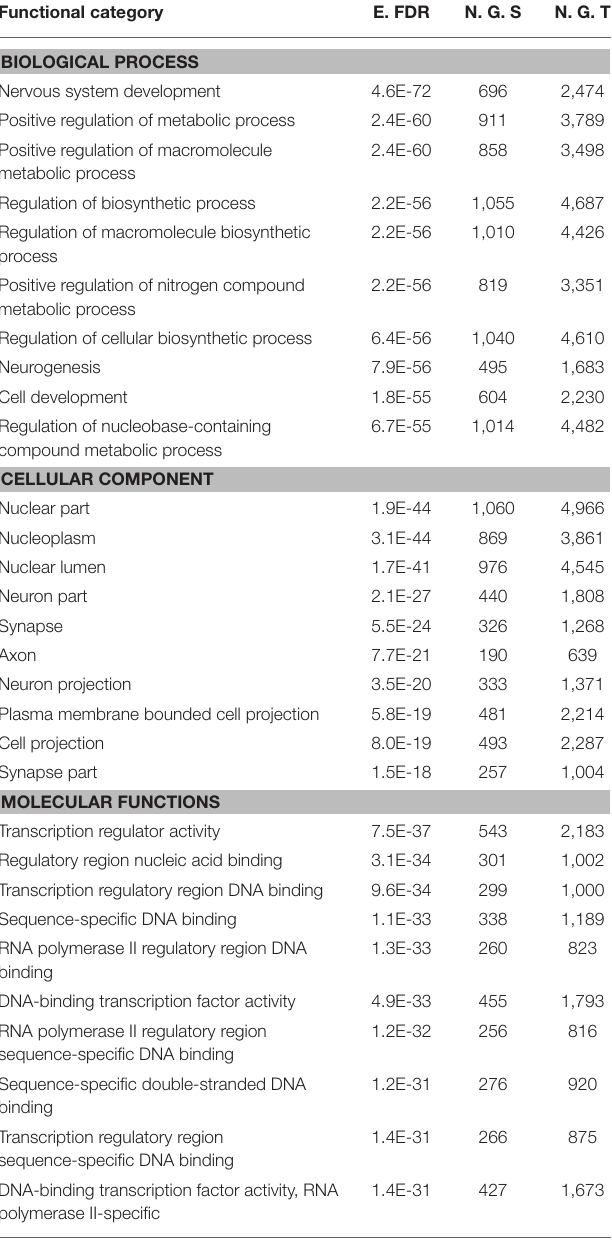
TABLE 2 | Gene ontology enrichment analysis of differentially expressed miRNAs was divided into three groups: biological processes, cellular components, and molecular functions.